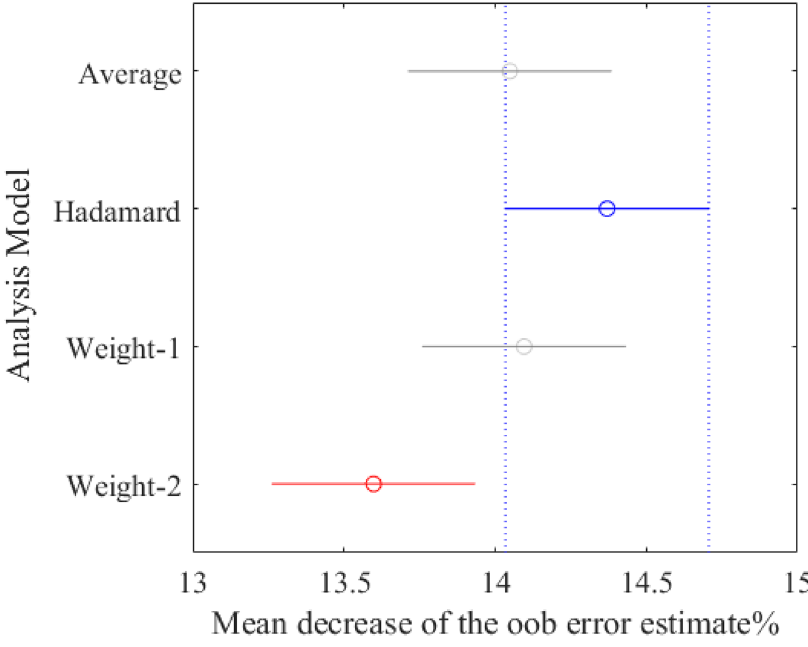
Fig 6. Multiple comparison of decreaseson the oob error estimates for the three contrast models.